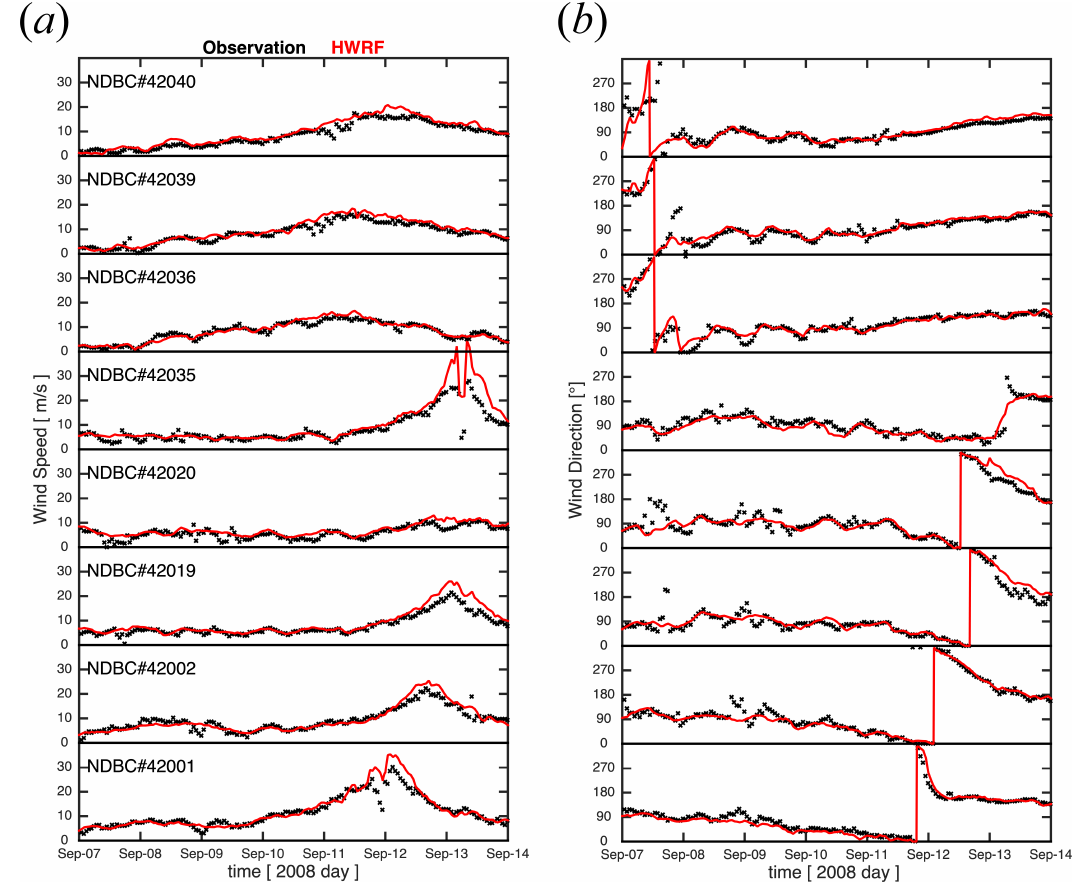
Figure 13. Atmospheric model validation at the National Data Buoy Center (NDBC) buoy locations, model (red) versus observation (black): ( a ) Wind speed; ( b ) wind direction. All model configurations and results are pre-decisional and for official use